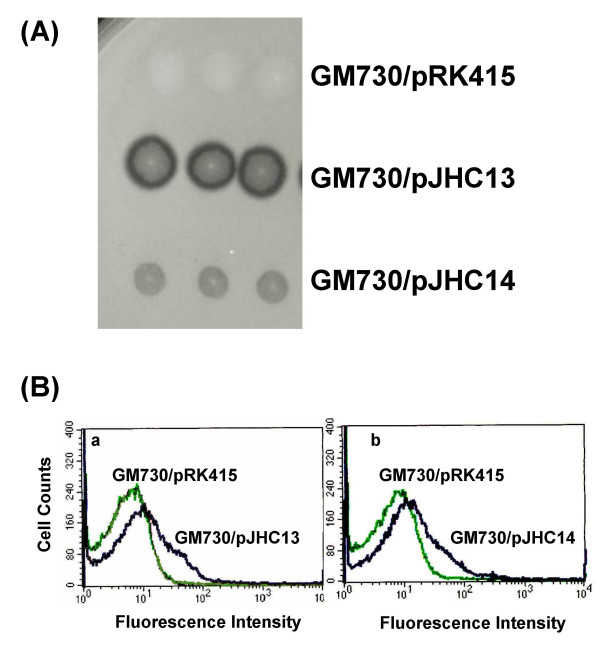
(A) Halo-formation around the colonies of recombinant P. putida GM730 cells. (B) Probing the surface display of the lipase by flow cytometry using rabbit-anti-TliA antibodies and fluorescein-labeled ant-rabbit IgG antibodies. a. Histogram of GM730/pRK415 (control cells) and GM730/JHC13 (INPNC-TliA displaying cells). b. Histogram of GM730/pRK415 (control cells) and GM730/JHC143 (INP-TliA displaying cells).